Question: Condense the content of this figure into a single sentence.
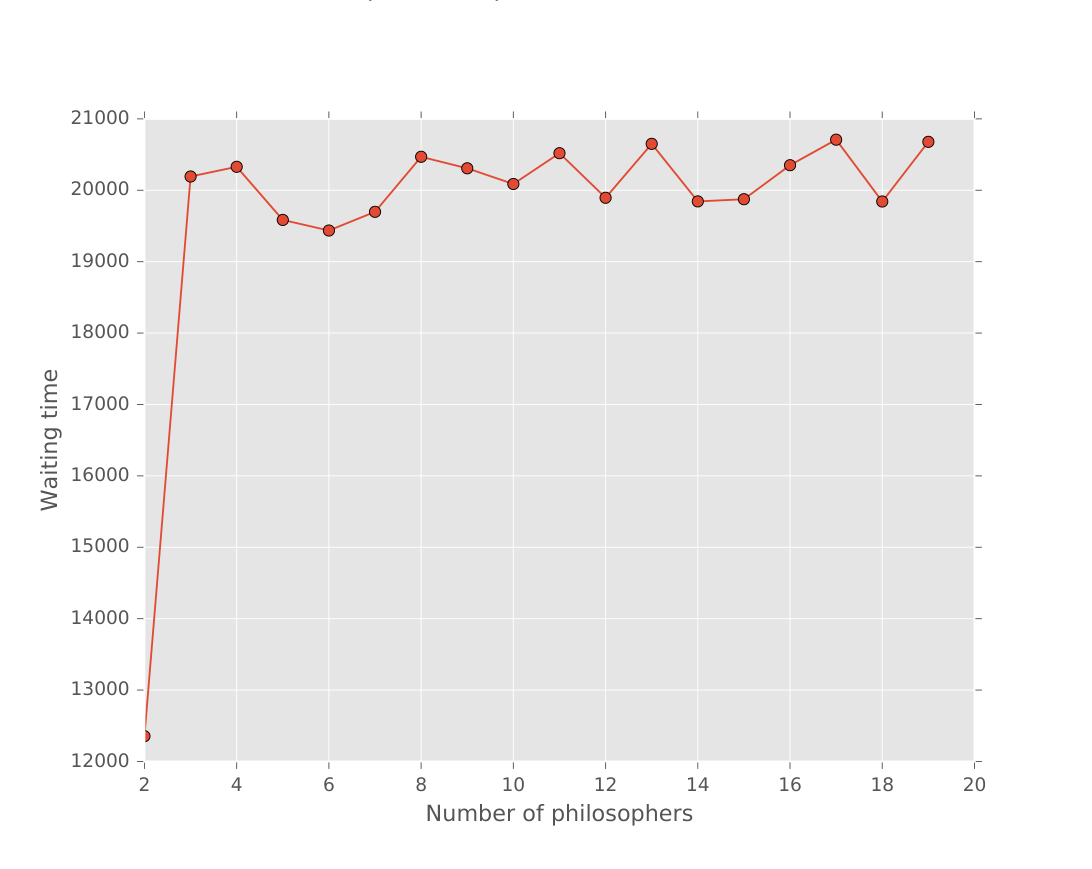
Answer: Waiting time vs. the number of philosophers